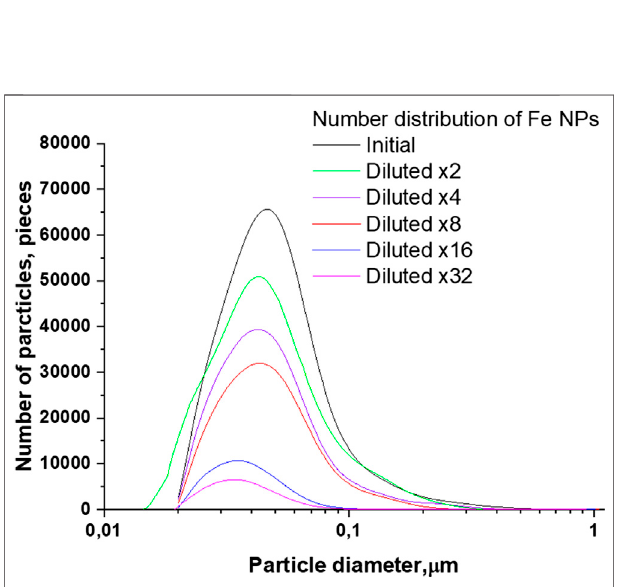
FIGURE 4 | The distribution of the mass of Fe nanoparticles by size depending on the amount of dilutions of the initial colloid.